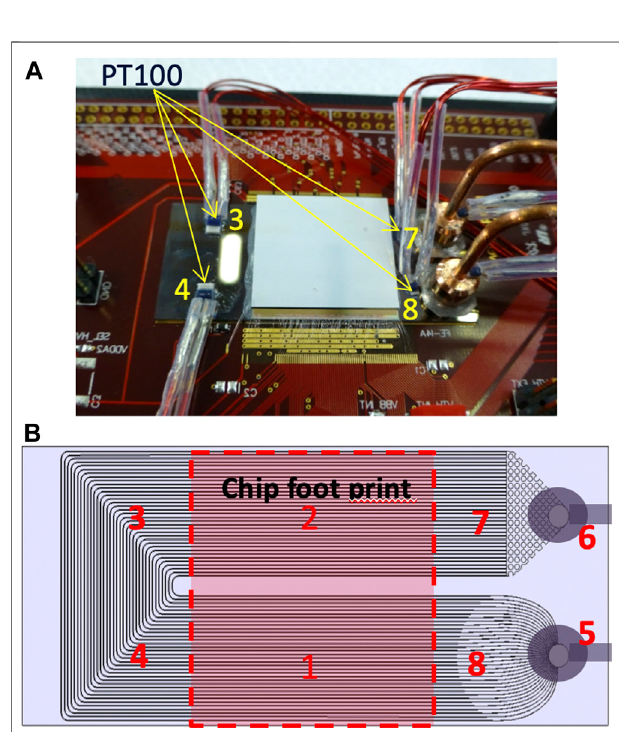
FIGURE 5 | (A) Position of the FP100 temperature sensors on the PCB board. (B) Numbered position of the PT100 thermal sensors on the microchannel chip. Sensors 1 and 2 were glued on the back of the module and were therefore about 400 µm away from the channel